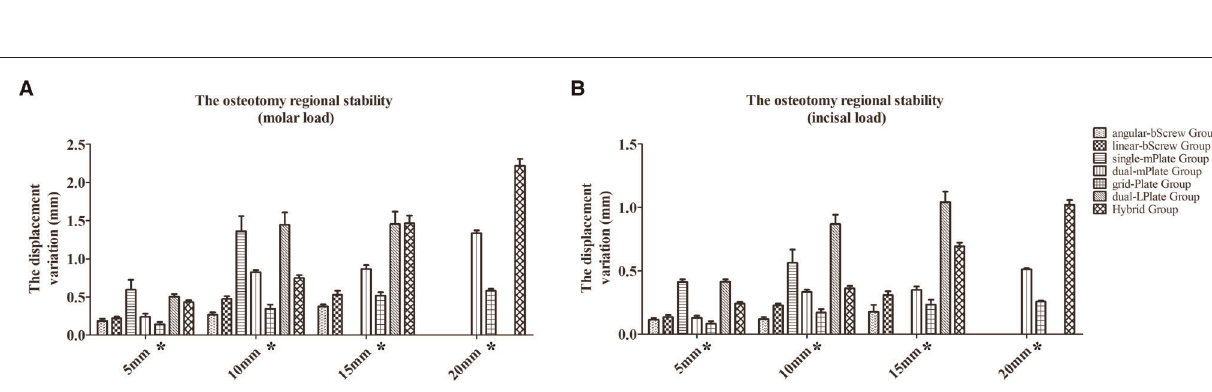
FIGURE 2 | Construct stiffness outcomes of the distal osteotomy segment under molar ( A ) and incisal ( B ) load conditions. * p <0.05.